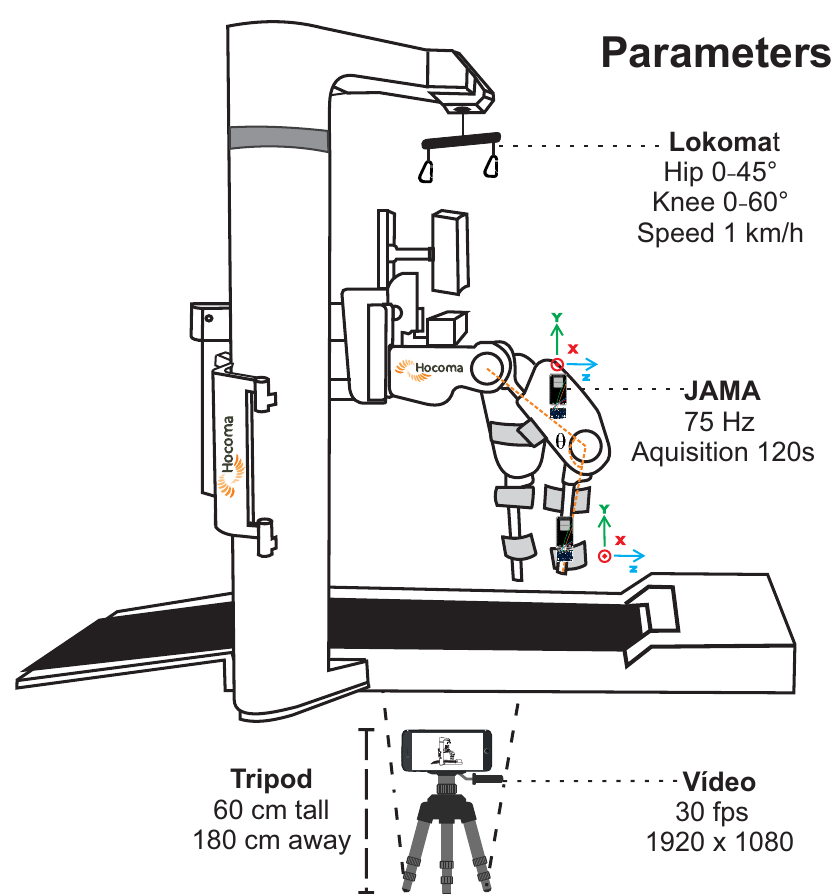
Figure 3. Experiment 1. Figure shows Lokomat schema (sidebars removed for better viewing) and parameters used for data acquisition. Two JAMAs were positioned on the side of the robotic leg, one above and the other below the knee joint, using 75 Hz as the acquisition frequency. Camera was positioned 180 cm away on a 60 cm height tripod. Video was recorded in full HD resolution at 30 fps. Lokomat was configured for a 45 ◦ hip and 60 ◦ knee ROM and simulating a 1 km/h gait. A comparison performed between orientations provided in quaternions by Vicon and Xsens showed a significant difference. Thus, Vicon’s data to compare with PyJama’s estimates were discarded. Probably, this difference was due to the positioning of Xsens sensors and Vicon’s body markers, which require some specific type of adjustment. The cal- ibration done by the authors considered the orientation of the bone of a virtual avatar [10], which was not directly related to the context of our work. Accelerometer, gyroscope, and magnetometer data to estimate the orientation using the filter algorithms implemented in PyJama were compared to Ground Truth. Comparisons were made using root-mean-square error (RMSE) and the mean absolute percentage error (MAPE) metrics. RMSE is the most common metric in studies with sensors [7], and MAPE is an error metric that is easier to be interpreted. For this experiment, joint angles were not calculated since the dataset does not provide